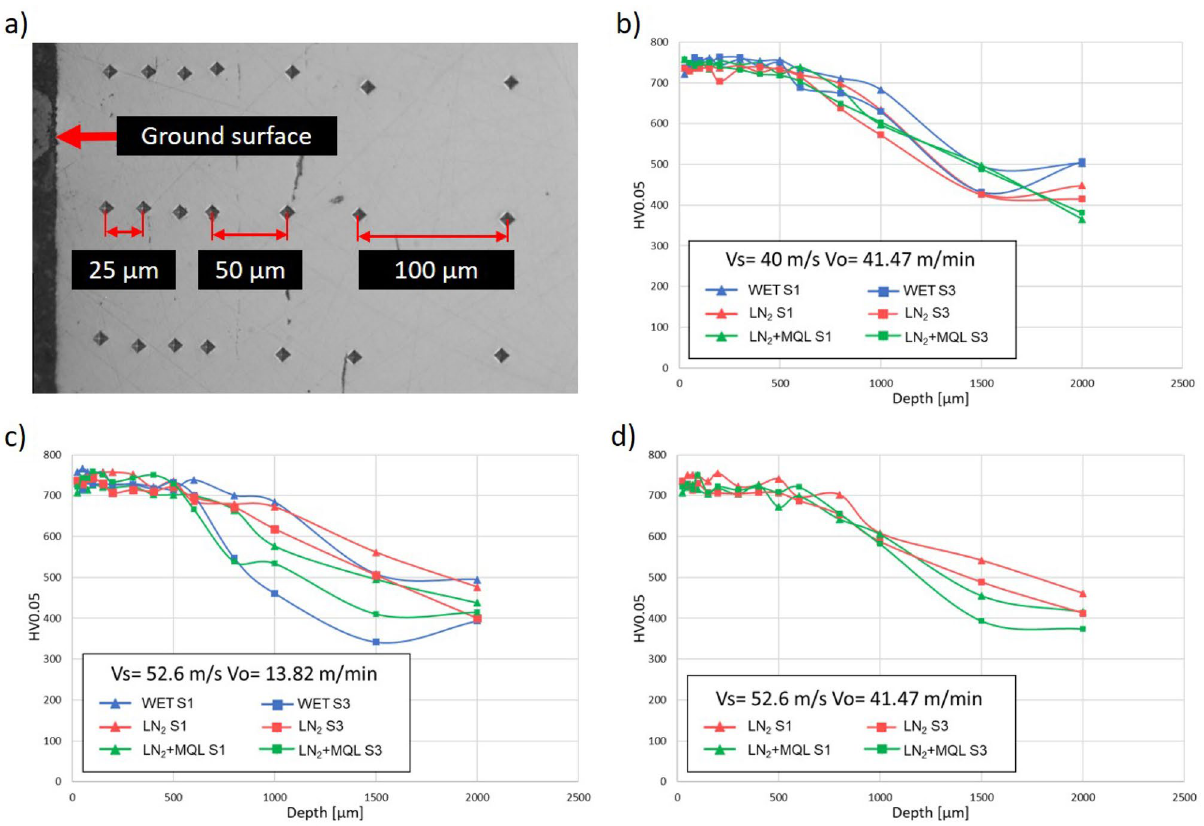
Figure 6. Microhardness profiles HV 0.05 for the best machining conditions. ( a ) Hardness test depths on the cross-section, ( b ) Vs = 40 m/s, Vo = 41.47 m/min, ( c ) Vs = 52.6 m/s, Vo = 13.82 m/min, and ( d ) Vs = 52.6 m/s, Vo = 41.47